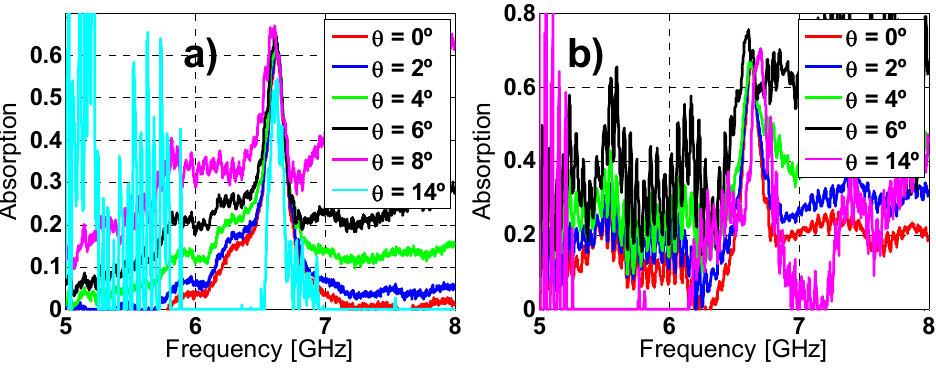
Figure 15. Absorption measurement results for different incident angles ( θ ) for both ( a ) TE; and ( b ) TM